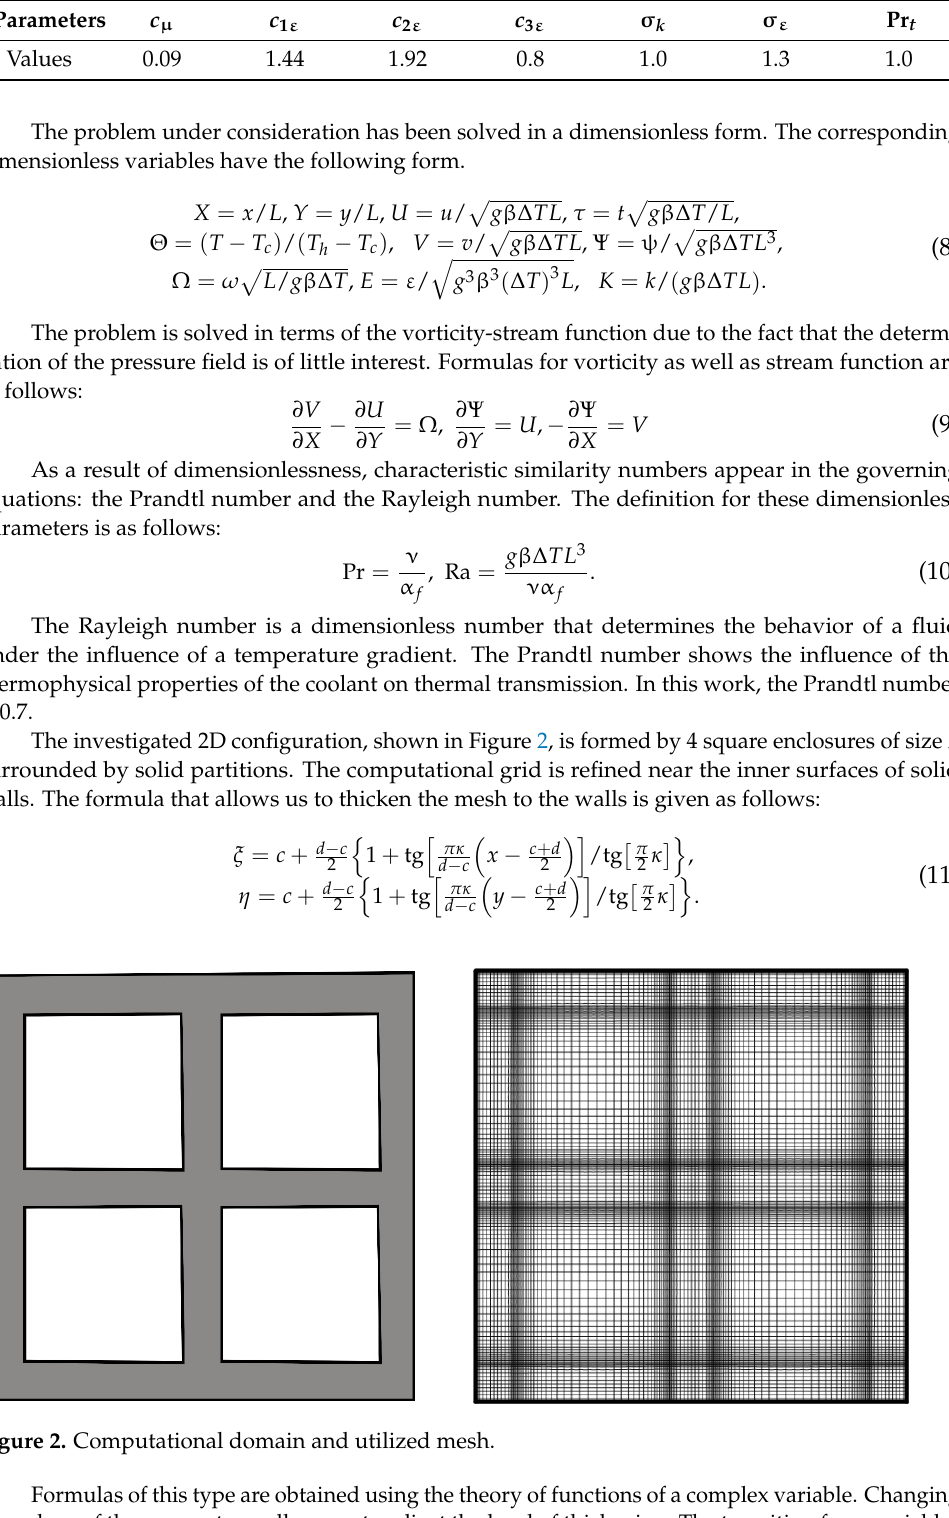
Table 1. Parameters of the k − ε turbulence model.